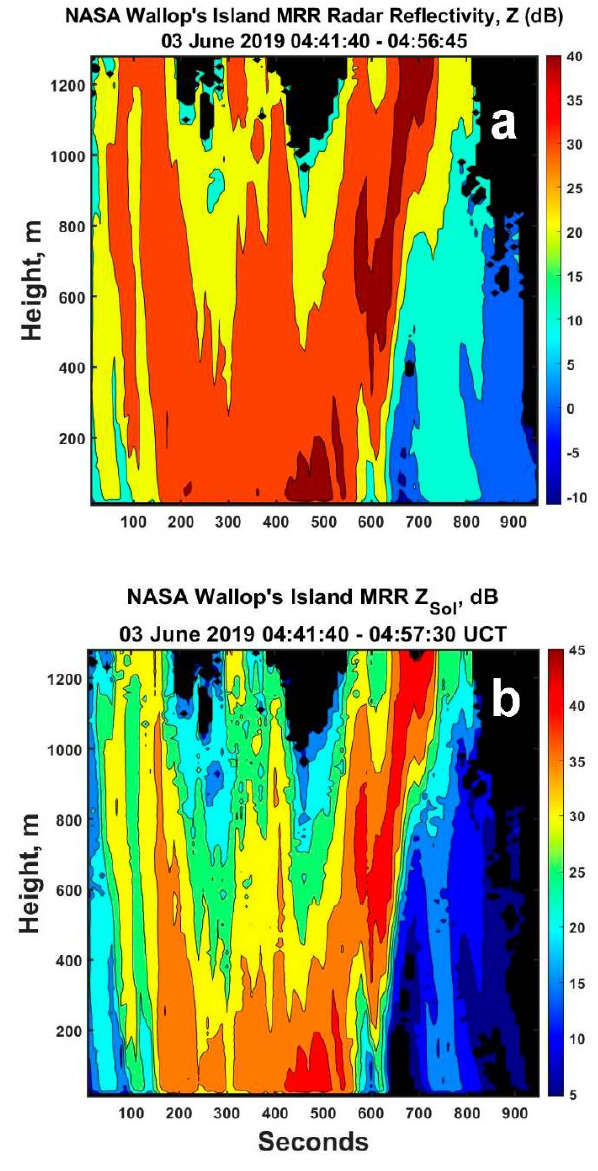
Figure 13. The time–height plots of ( a ) the observed radar reflectivity Z and ( b ) Z Sol from the solutions for the earlier, more convective time period on this day. Finer structure is apparent in ( b ), but the values are nearly identical on the whole, as indicated in the next figure. Black denotes no usable power observations after adjustment.